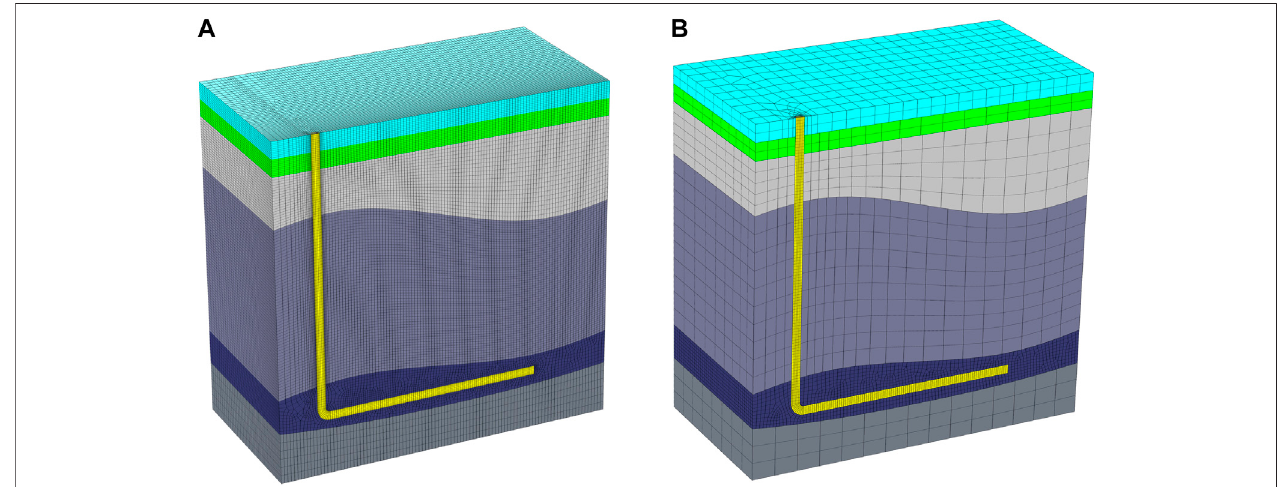
FIGURE 1 | Mesh subdivison (A) for the traditional modelling and (B) for the multi scale modelling.